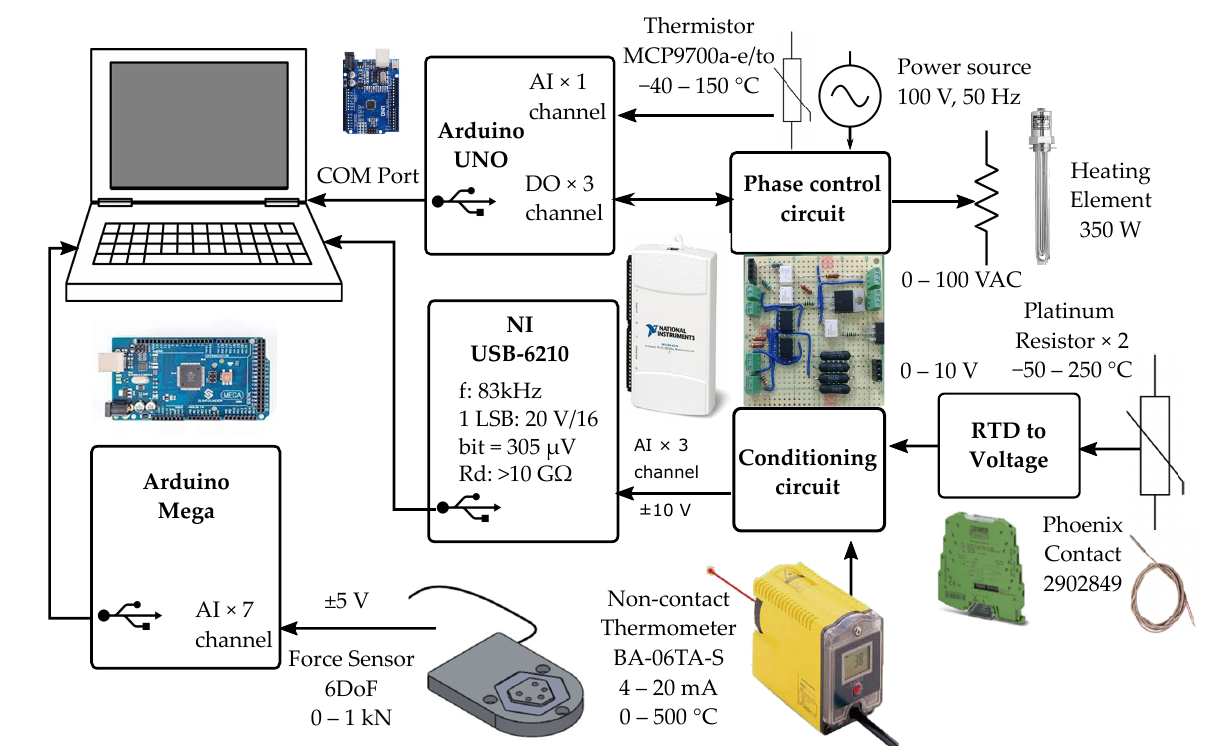
Figure 8. Zero-Flow (ZFSMALA) electronic block diagram.